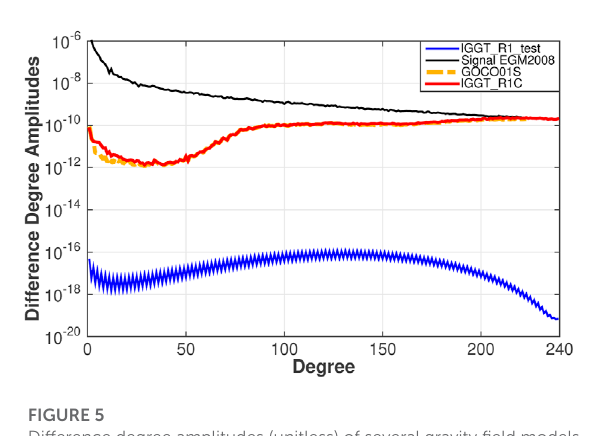
FIGURE 4 Cross classified storage of the normal matrix in the computer memory. Columns in the same color are stored in the corresponding processors. Each processor takes turns choosing a primary column and broadcasts it to other processors. The processor that broadcasts the primary column applies this column to the remaining m − 1 columns as elementary column transformation, while the other processors perform elementary column transformation on m columns using the received primary column. The loop continues until the last primary column with the number n − 1 is broadcast and the elementary column transformation is completed.